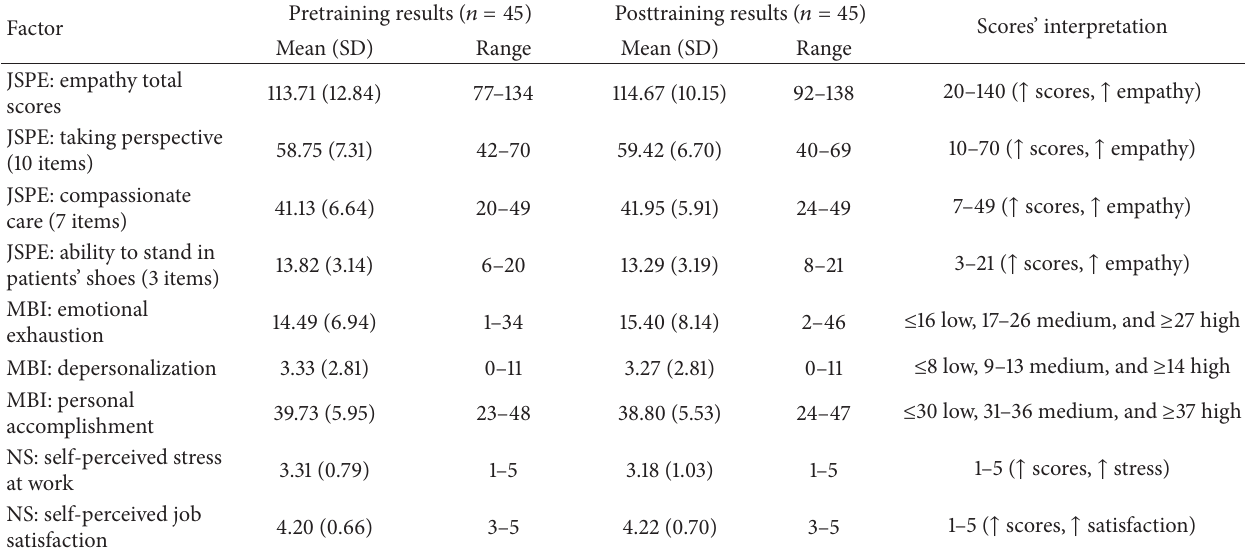
Table 2: Descriptive results ( 𝑁 = 90